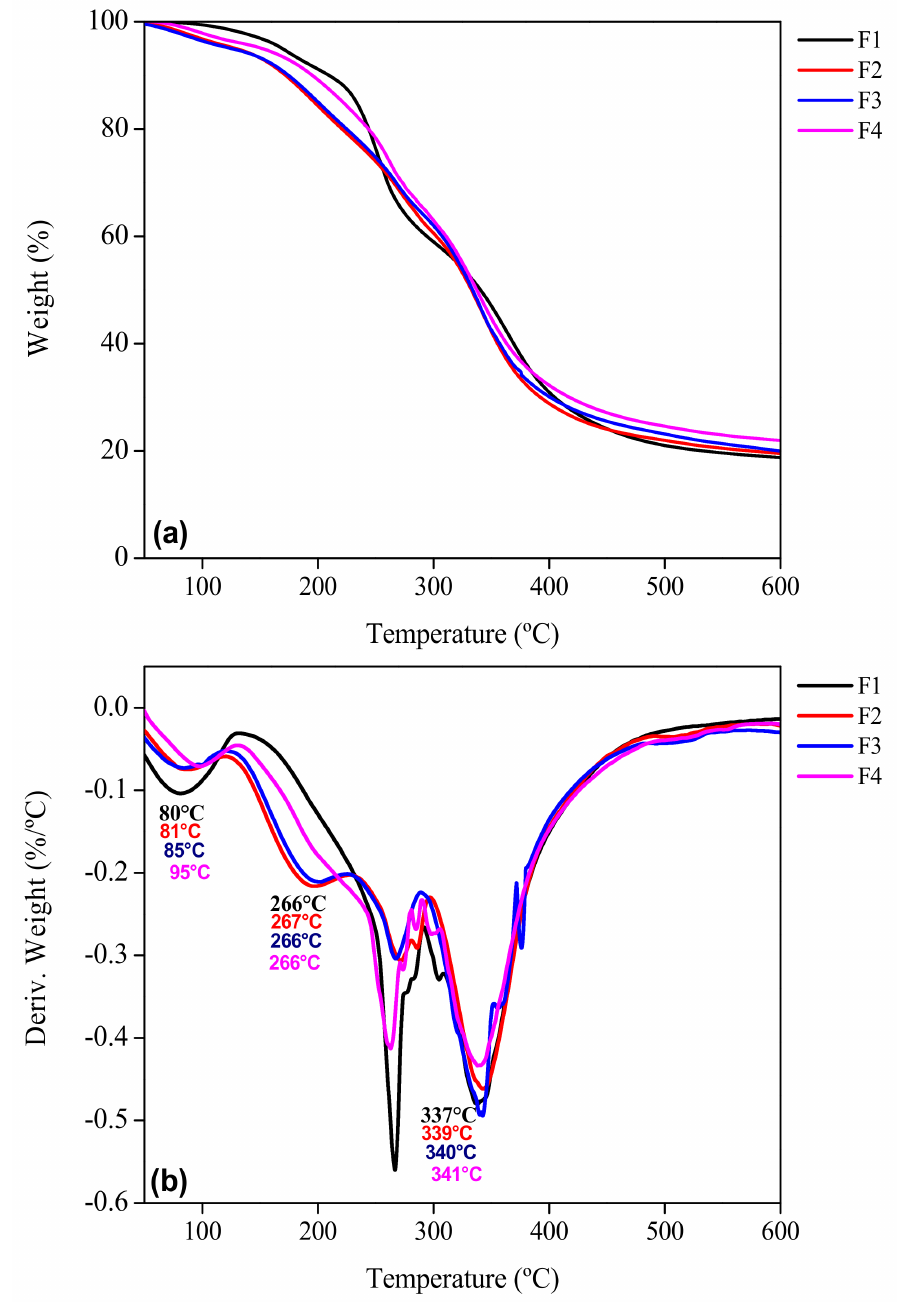
Figure 8. TGA profile of the reinforced gelatin biofilms. ( a ) Weight as a function of temperature and ( b ) first derivative of the weight curve. F1: control film; F2–F4: biofilm with